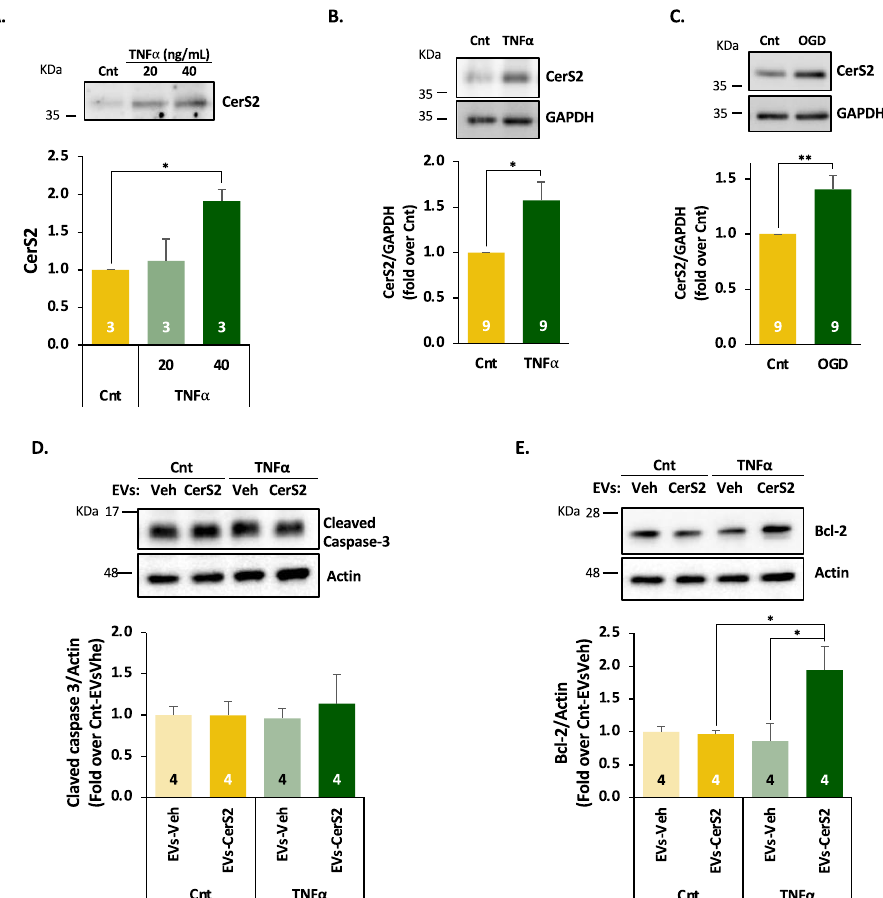
Figure 4. CerS2 expression is induced in an inflammatory context leading to the expression of antiapoptotic factors. ( A ) Representative image (top) and quantification (bottom) for CerS2 levels in EVs secreted to the medium of cortical cultures upon vehicle (Cnt) and TNF α (20 and 40 ng/mL) treatment showing an increase in CreS2 level in secreted EV with 40 ng/mL of TNF. ( B , C ) Representative images ( top ) and quantification ( bottom ) for CerS2 levels in total lysates from neuronal cultures challenged with TNF α ( A ) or subjected to metabolic stress ( B , OGD) showing an increase in CreS2 levels. ( D , E ) Representative images ( top ) and quantification ( bottom ) for cleaved caspase-3 ( D ) and Bcl-2 ( E ) in differentiated SH-SY5Y treated for 24 hours with vehicle (Veh) or CerS2-loaded EVs (CerS2) in the presence or absence of an inflammatory challenge (TNF ⍺ ). Our results show that mild inflammatory challenges or EVs do not induce apoptosis in differentiated SH-SY5Y but that CerS2-loaded EVs lead to increased antiapoptotic factors (Bcl-2) in an inflammatory context. One- sample t -test (B,C) and ANOVA followed by Tukey post hoc (A,D,E). * p -value < 0.05, ** p -value < 0.01.